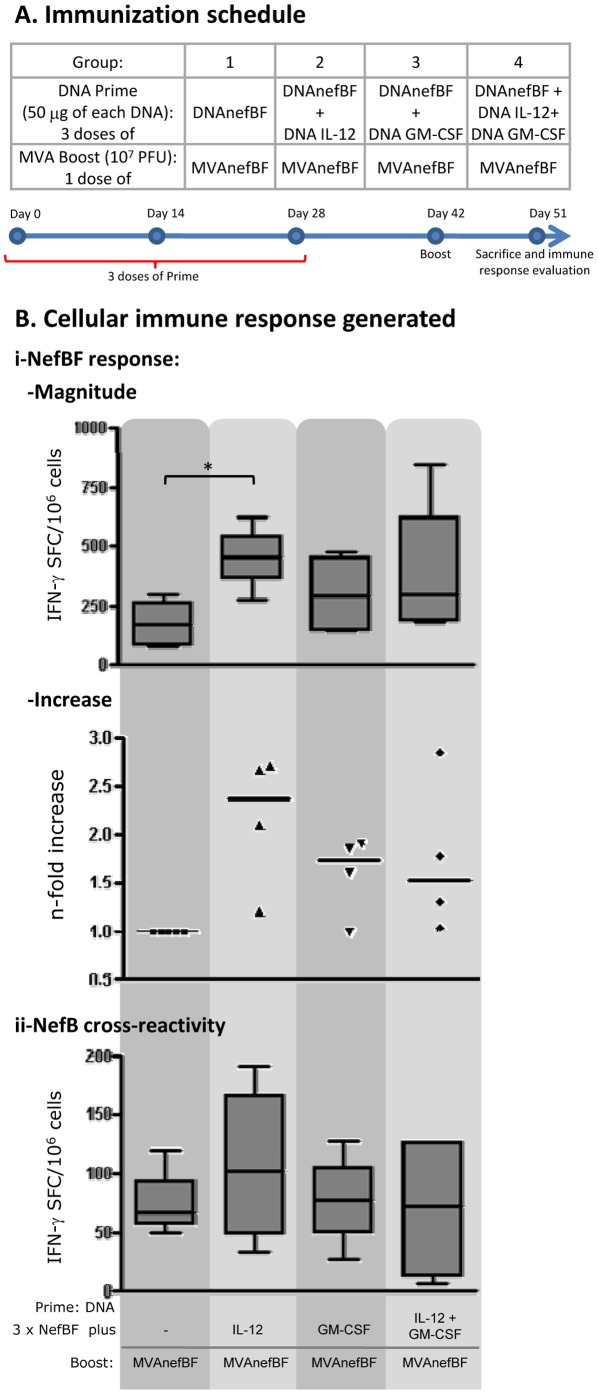
IL-12 and GM-CSF incremented the magnitude of the specific immune response.
A) Immunization schedule: Groups of 4 Balb/c mice received the different immunization regimes depicted. Immunization doses (both priming and boost doses) were spaced by 14 days. B) Nine days after the MVAnefBF boost dose, cellular immune responses against a pool of peptides representing i- NefBF or ii- NefB were evaluated in the spleen, by quantifying specific IFN-γ secreting cells by ELISPOT; i- Magnitude of the NefBF (homologous) response; n-fold increase represents the increments in the responses generated in relation to those found in the control group. ii- Magnitude of the cross-reactivity responses detected against NefB. Data represent the median values found in 4 to 5 independent experiments. Background values found in negative control wells were subtracted (5 to 50 spots/106 cells). Mann Whitney test was applied, comparing NefBF responses between groups (* p<0.05). For the box and whisker plots, the horizontal line represents the median, the boxes represent the interquartile range and the whiskers represent the minimum and maximum values.